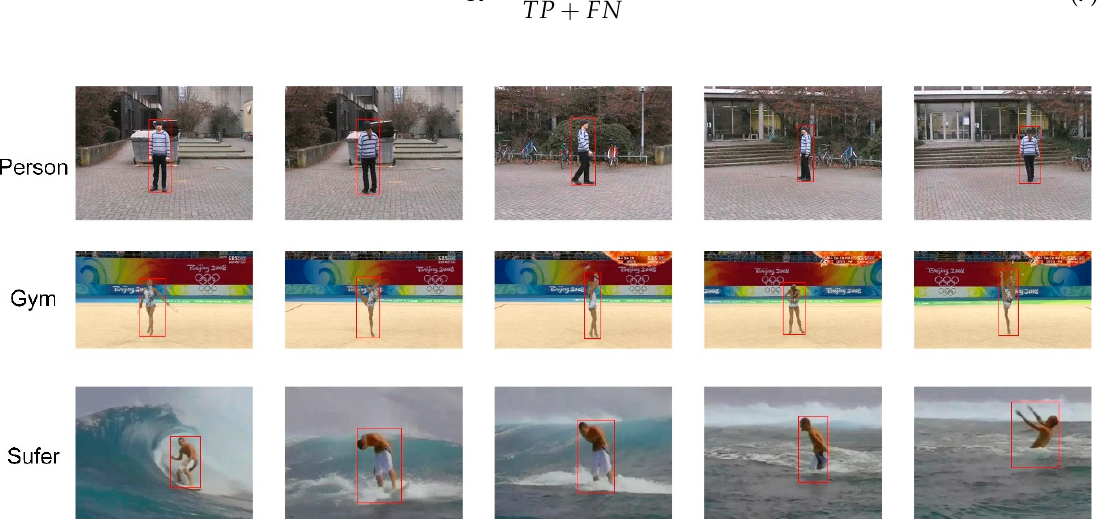
Figure 7. Image sequences for the Vojir dataset.